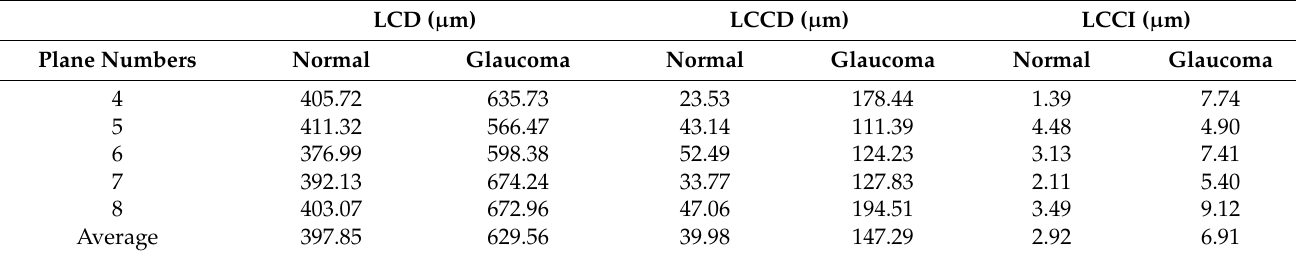
Figure 13. Comparison of normal and glaucoma eye images: ( a ) A normal fundus image and an OCT image after the sampling operation; ( b ) the corresponding quantification results for the normal OCT image (cyan line is the BMO reference line, teal color curve is anterior LC curve, lime green color vertical line is LCD , magenta color line is width (w), and blue color line is LCCD. ( c ) A glaucoma fundus image and an OCT image after the sampling operation; ( d ) the corresponding quantification results for the glaucoma OCT image (cyan line denotes BMO reference line, teal color curve is anterior LC curve, lime green color vertical line is LCD , magenta color line is width (w), and blue color line denotes the LCCD . Scale bar: 400 µm. Table 4. Comparison of the quantification of parameters in the normal and glaucoma